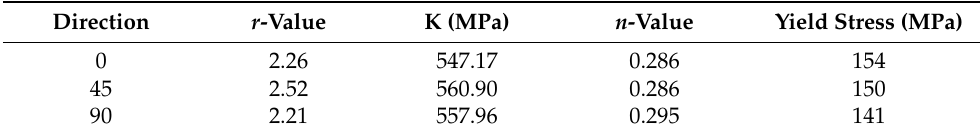
Figure 1. Uniaxial tension tests for ( a ) low-carbon steel sheet and ( b ) high-strength steel sheet. Table 1. Material parameters along different directions (low-carbon steel).